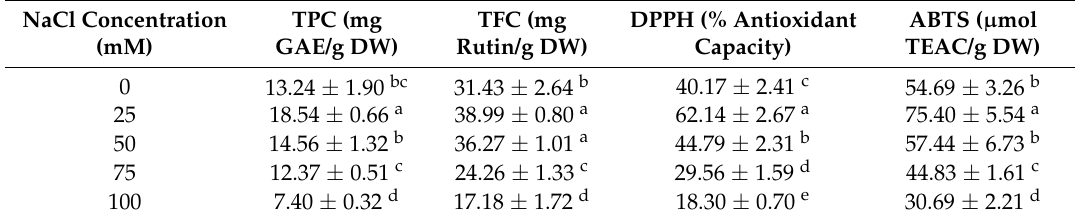
Table 1. Total phenolic and flavonoid content and antioxidant activity of S. tenuifolia leaves influenced by salt stress.